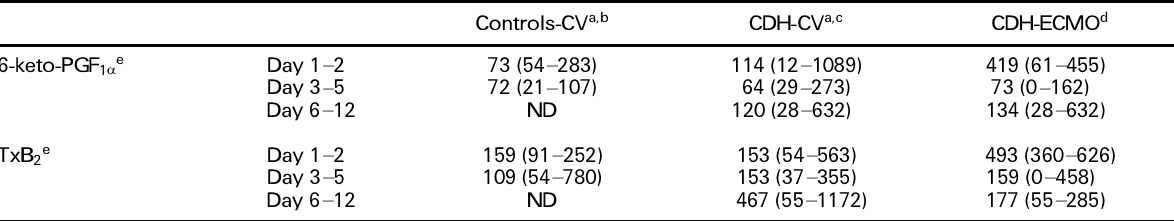
Table 2. Prostanoids in BAL ¯ uid of ventilated controls and CDH patients, and in CDH patients treated with